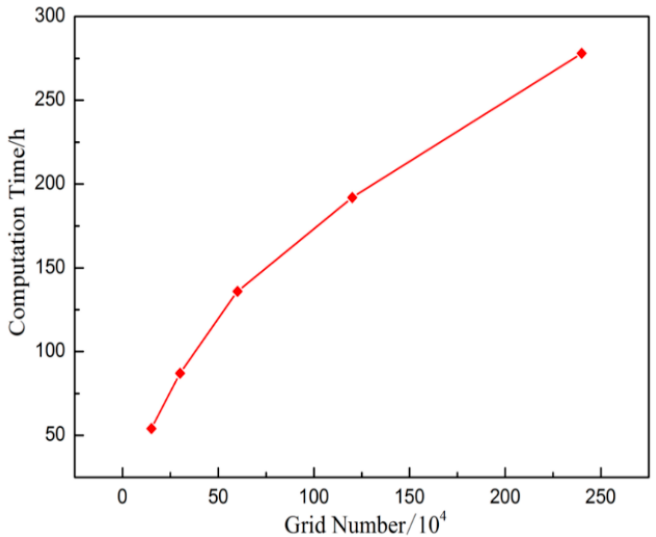
Figure 5. Effect of the grid number on computational time.